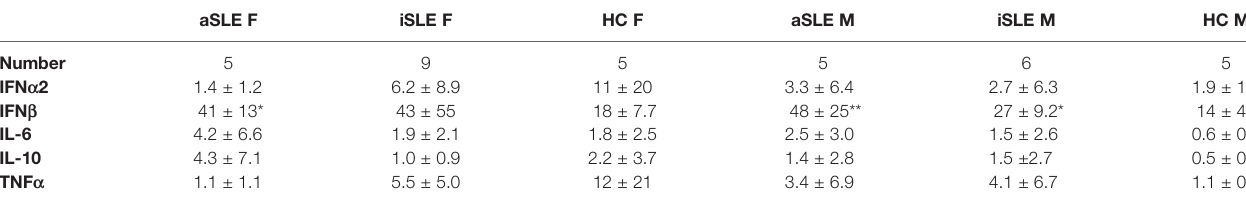
TABLE 2 | Cytokine pro fi les.